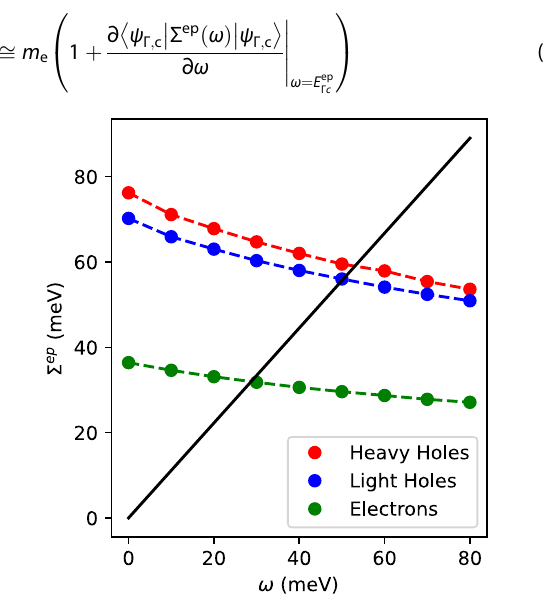
Fig. 1 Real part of the self-energy for zb-GaN. Real part of the expectation values of the phononic part of the self-energy Σ ep ( ω ) calculated at the Γ -point for the (lowest) electron band (blue), heavy hole bands (red) and light holes (green) for zinc-blende GaN. The zero of the energy axis corresponds to the VBM for the holes and to the CBM for the electrons. Only for the electrons the values on both axis have been multiplied by the factor ( − 1). The dashed lines are a guides for the eye. The solutions of Eq. (17) are found at the crosses with the black line Σ ep ( ω ) = ω